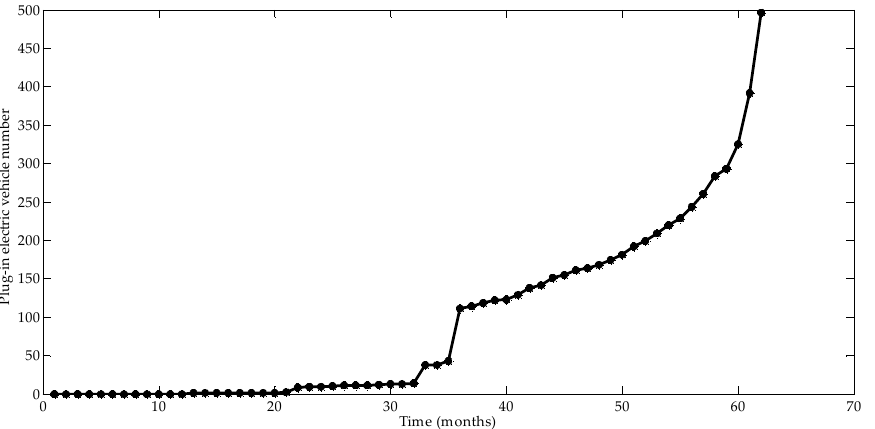
Figure 2. Monthly number of PEVs from 2018 to 2023. The charging process of an electric vehicle involves converting AC power from the grid into DC power to charge the vehicle’s battery. This conversion process can result in power losses, as some energy is dissipated as heat. Additionally, the charging process can increase the load on the distribution system, leading to increased losses due to higher current flow and voltage drop [13]. The minimization impact of PEV charging on power losses in the distribution system can be taken by the following works of literature.